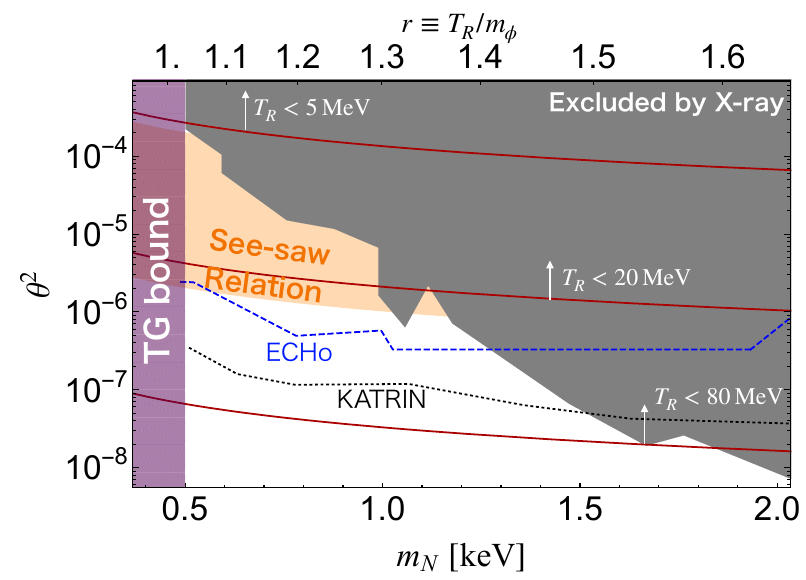
Figure 3 . Parameter region for a Dirac sea DM of RHN in m N - θ 2 plane. On the upper axis, we also show the predicted r = T R /m φ for the Dirac sea DM with g = 2 , g ? = g ?,s = 11 . Above the red solid lines, the reheating temperature should be smaller than T R = 5 MeV , 20 MeV , 80 MeV